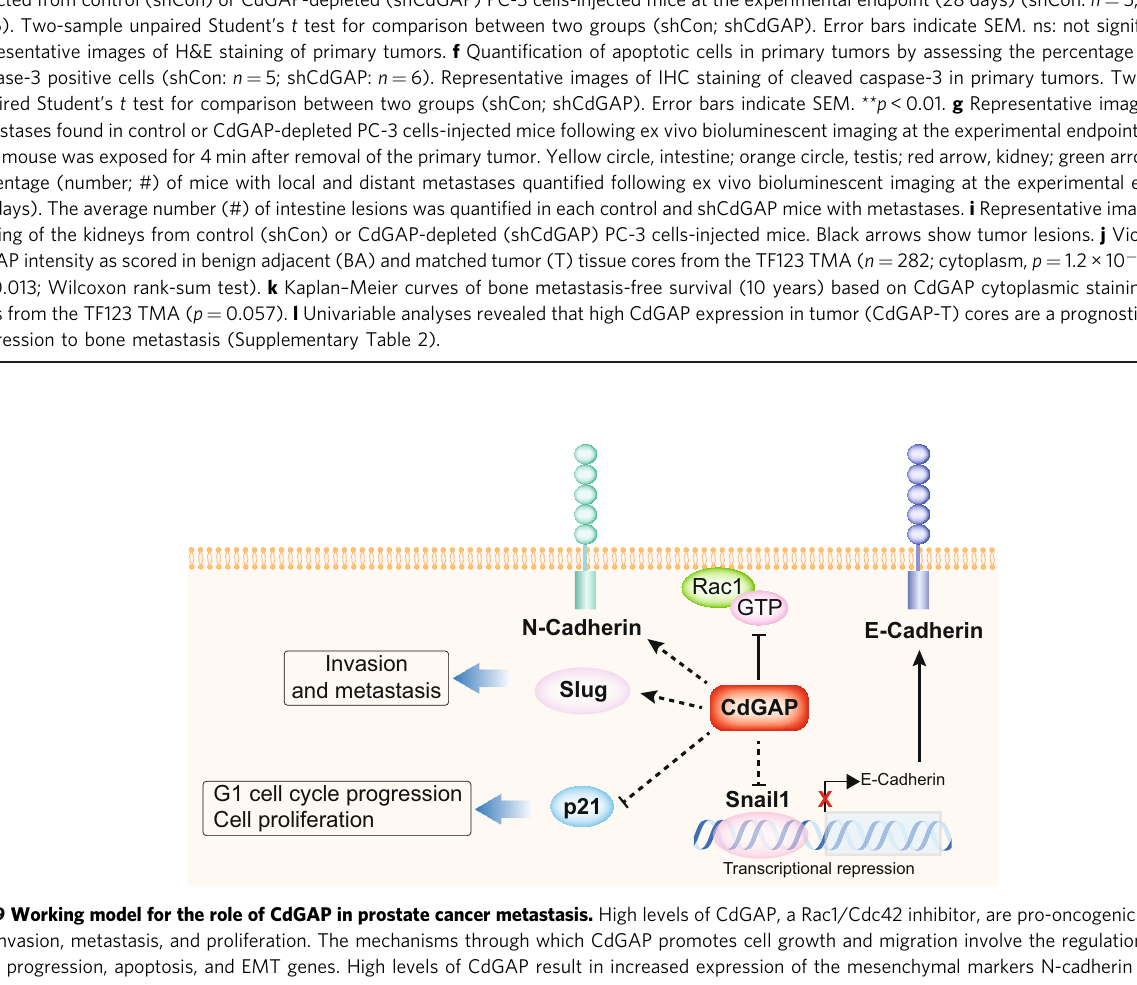
Data processing . Microarray raw data (.CEL fi les) were read and preprocessed by Oligo Bioconductor package_1.50.0 41 . Probe intensities were summarized using Robust Multi Array Average (RMA) algorithm. This step includes a background correction, a quantile normalization, and a log2 transformation of the data. Probes with low intensity were fi ltered and the batch effect was corrected using the ComBat-function of the sva Bioconductor package_3.34.0 42 . Hugo Gene Symbols were mapped to each probe in the platform using hgu133plus2.db annotation_3.2.3 package 43 and genes with multiple probe sets were collapsed using CollapseRows- function ( “ MaxMean ” argument) from WGCNA package_1.69 44 . TCGA RNA-seq sequencing read counts were normalized for sequencing depth using the size factor method implemented in Deseq2_1.26.0 package 45 .